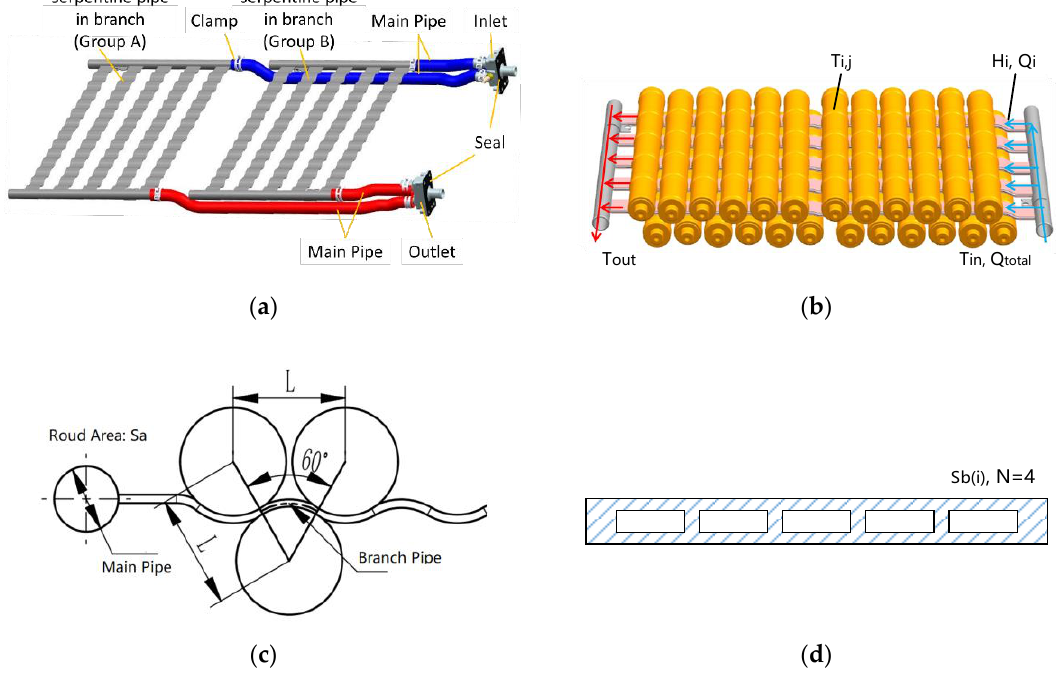
Figure 3. Liquid-cooling system. ( a ) A 3D view of the two cooling modules, including the in/out rubber pipes connected in parallel; ( b ) schematic of the cooling module; ( c ) schematic side view of the cooling module and the battery cell; ( d ) cross-sectional view of the serpentine pipe (with internal walls).